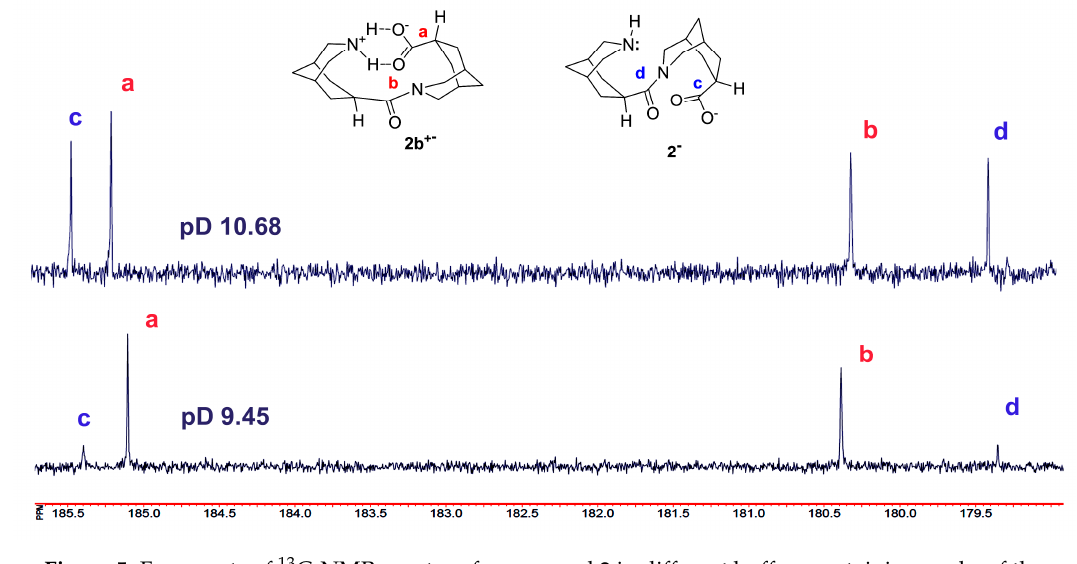
Figure 5. Fragments of 13 C-NMR spectra of compound 2 in different buffers containing peaks of the carbonyl carbon atoms.